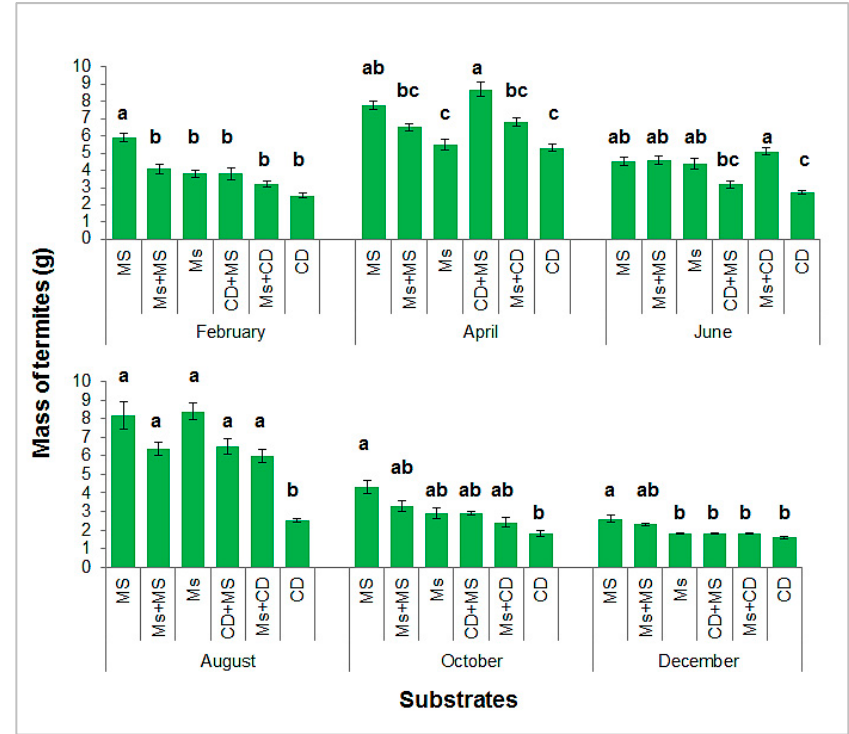
Figure 5. Average masses of dry termites harvested per container according to the substrates (MS = maize stems; Ms + MS = maize cobs + maize stems; Ms = maize cobs; CD + MS = cow dung + maize stems; and Ms + CD = maize cobs + cow dung; CD = cow dung). Error bars represent standard errors. Histograms with the same letter, in the same month, are not significantly different at the 5% level.